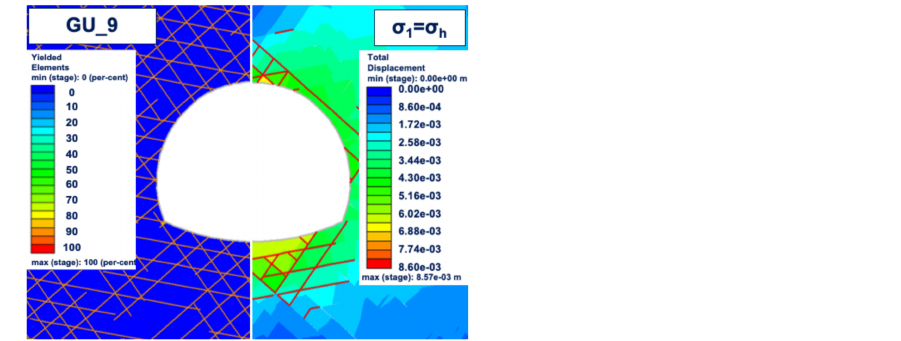
Figure 15. Numerical results of the five Geotechnical Units (GU_5–9) expressed in total displacements and yielded